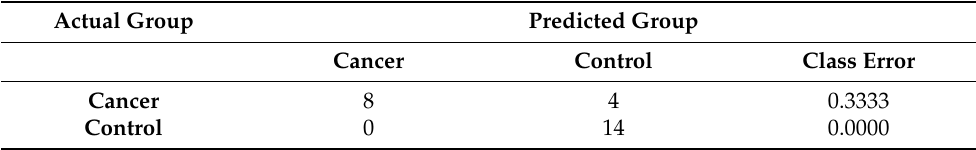
Table 5. Random forest prediction accuracy applied on the testing set made from 20% of stage 1 endometrial cancer cases and controls ( n = 26, cancers = 12, controls = 14) .